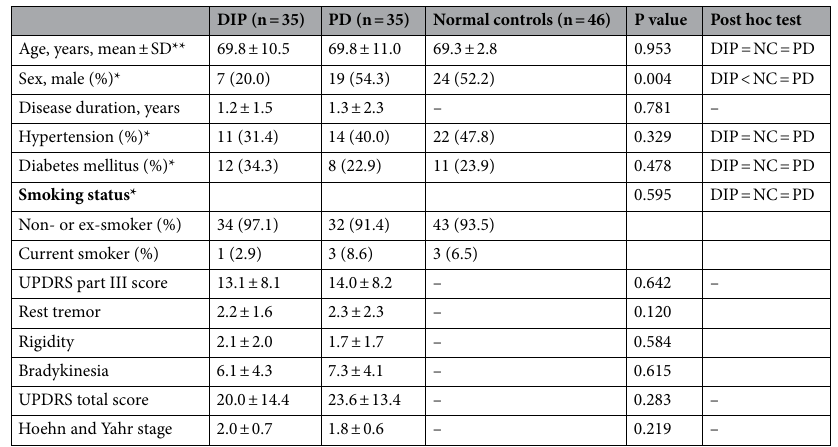
Table 1. Clinical characteristics of the three groups. Values represent mean with standard deviation or number of patients (percentage). Analyses were performed using independent sample t-testing, * χ 2 testing, and ** one way analysis of variance. UPDRS Unified Parkinson’s Disease Rating Scale.